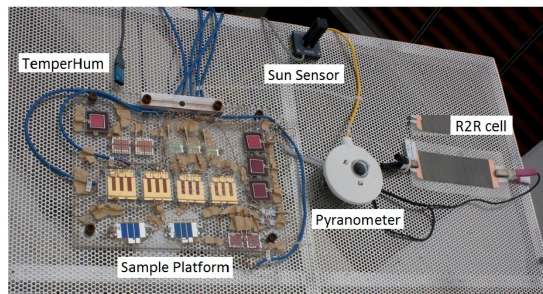
Figure 4. Cells used in this study mounted on the outdoor solar tracking platform along with